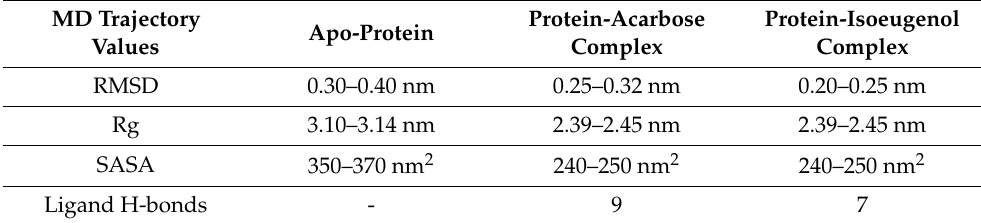
Table 4. MD trajectory values of isoeugenol and acarbose complexed with α